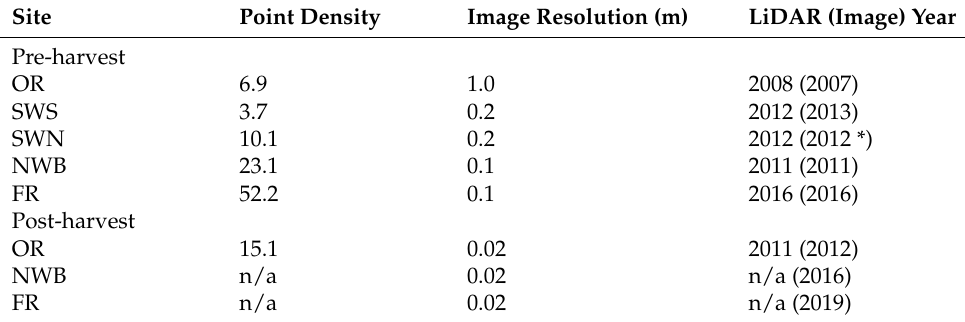
Table 2. Point cloud and imagery characteristics and acquisition years. * Note imagery from SWN-15 from 2013 similar to